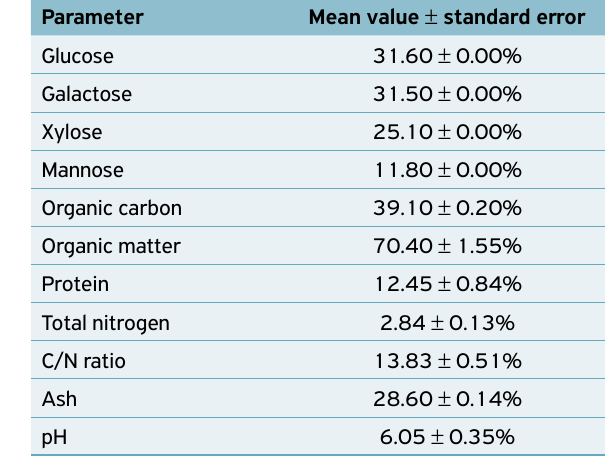
Table 1. Chemical composition of immersion water of banana